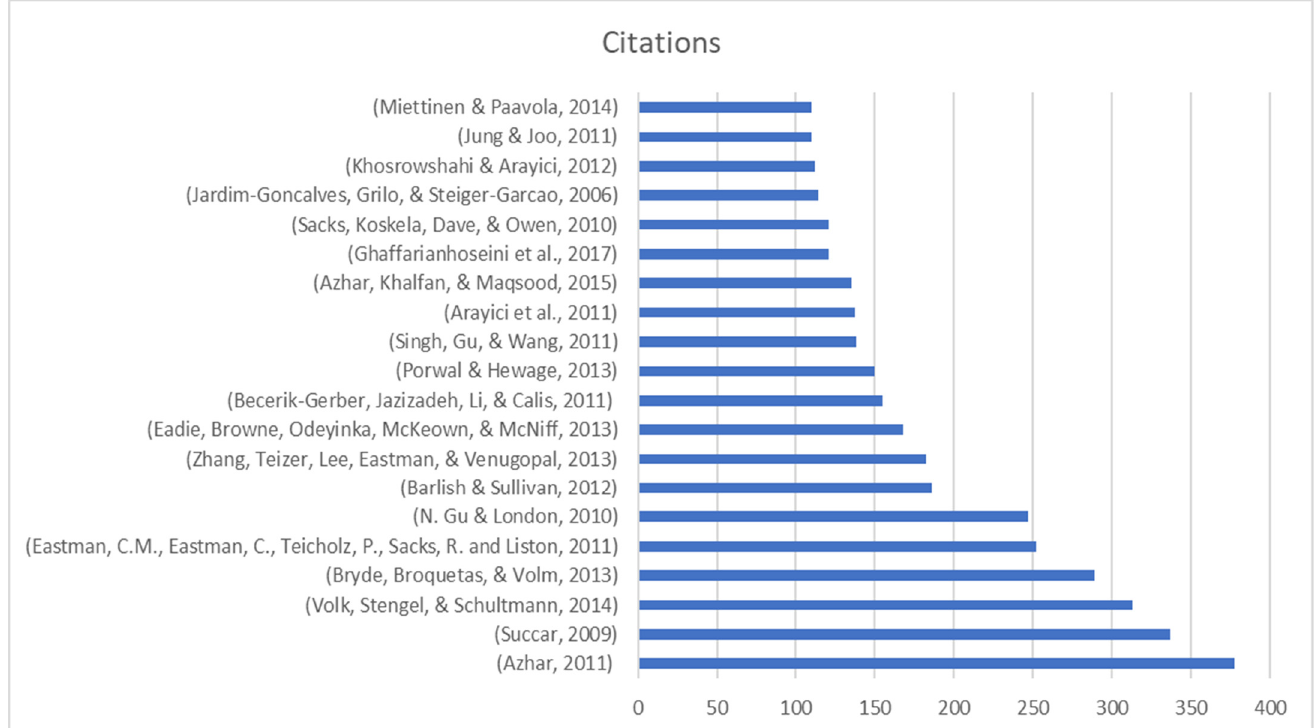
Figure 7. Authors with the strongest citation bursts.